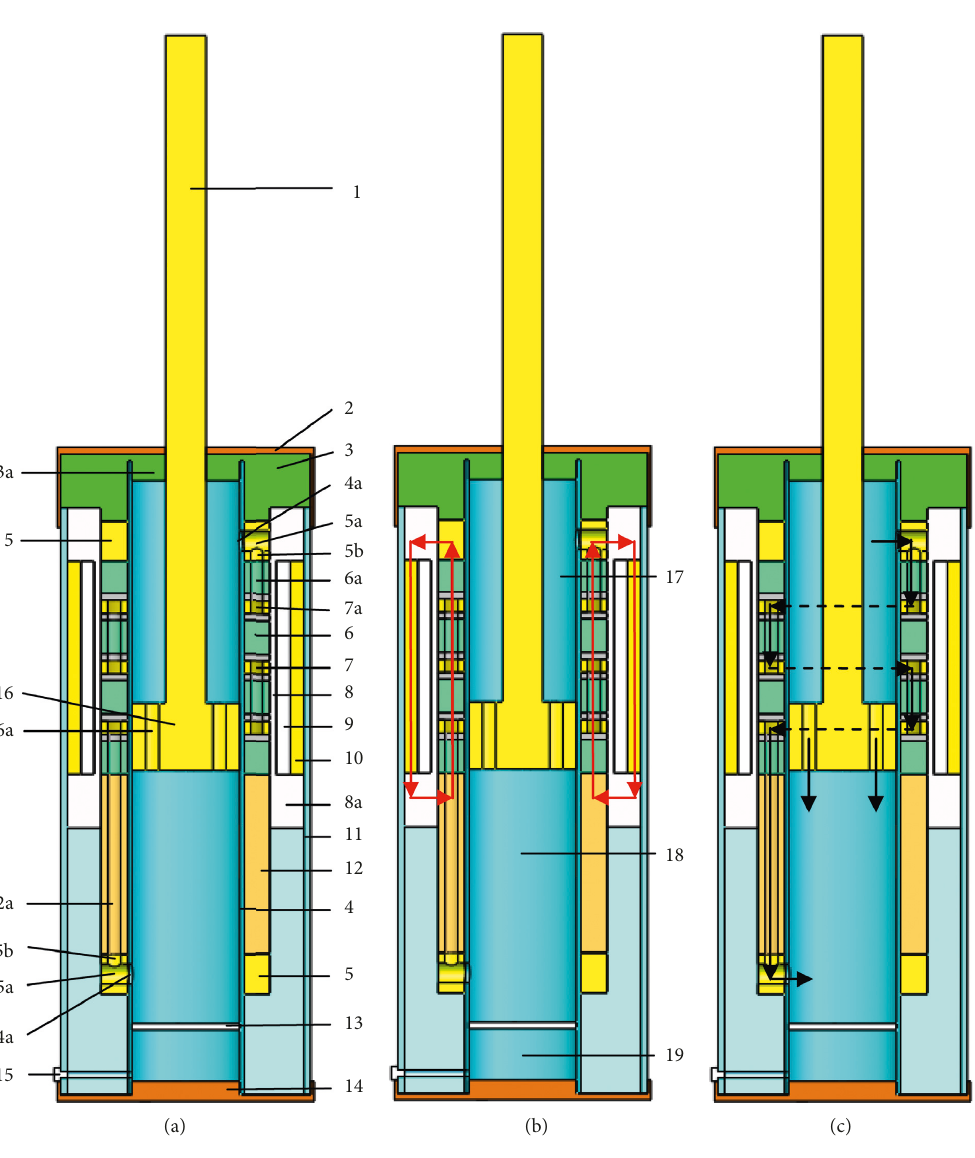
Figure 42: Schematic diagram of MR damper based on multistage circumferential flow mode: 1, piston rod; 2, upper end plate; 3, upper retaining plate; 3a, sealing and rod guiding; 4, inner tube; 4a, the first hole; 5, chuck; 5a, the second flow hole; 5b, the third flow hole; 6, ferromagnetic core; 6a, the fourth hole; 7, circumferential channel; 7a, the fifth flow hole; 8, outer tube; 8a, end magnetic core; 9, electromagnetic coil; 10, magnetic cylinder; 11, housing; 12, supporting cylinder; 12a, the sixth flow hole; 13, the moveable wall; 14, lower end plate; 15, nozzle; 16, piston; 16a, through-hole; 17, rebound chamber; 18, compression chamber; 19, gas chamber